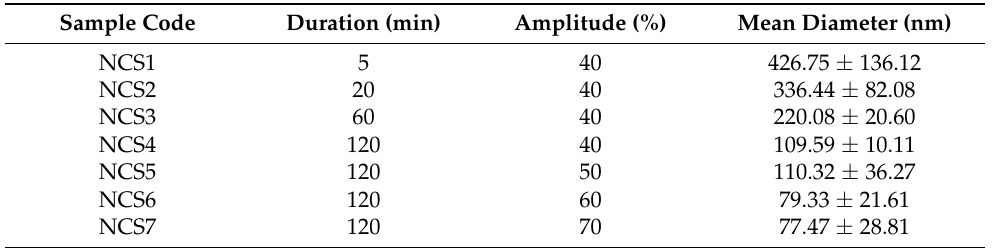
Table 2. Mean diameter and standard deviation of chitosan nanoparticles synthesized using different ultrasonication amplitudes and durations. Sample Code Duration (min) Amplitude (%) Mean Diameter